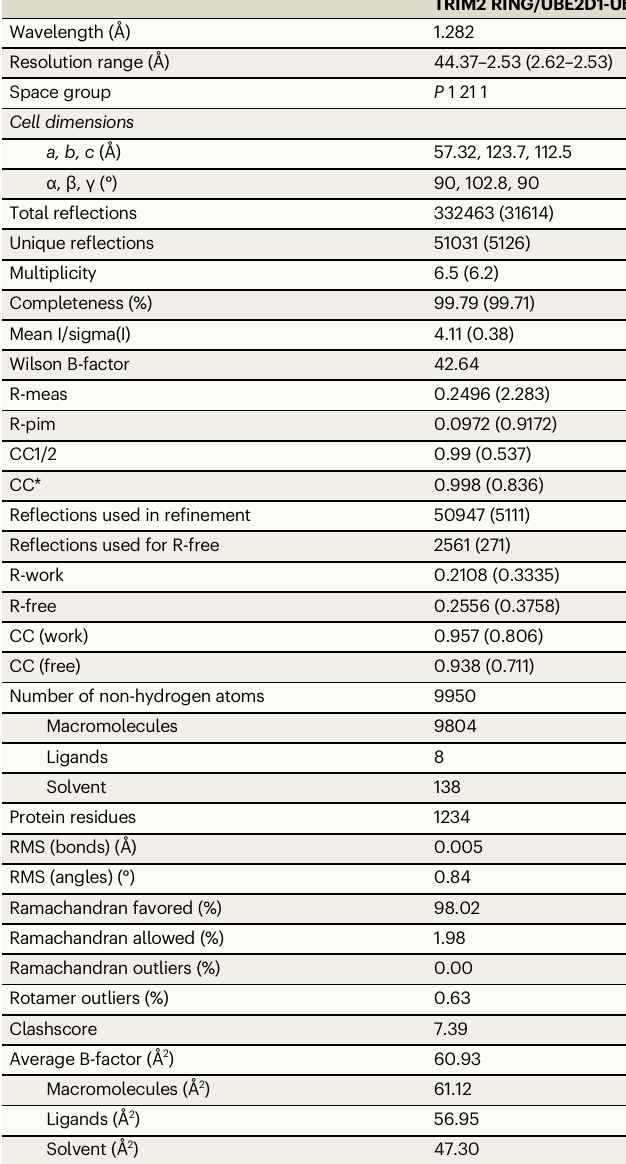
Table 1 | Data collection and re fi nement